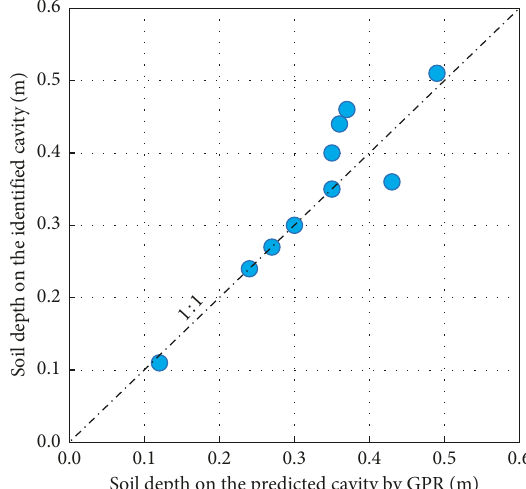
Figure 7: Relationship of the soil depth on the predicted cavity and the identified